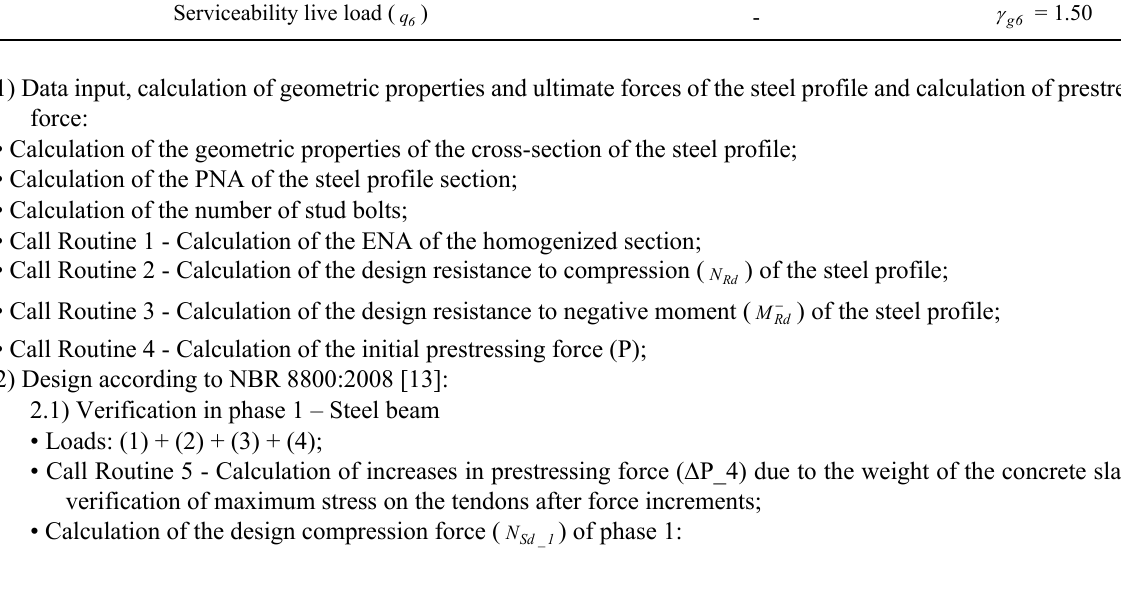
Table 2. Loads safety fator ( γ ) Loads Before Concrete Casting After Concrete Casting Weight of the steel beam ( ) ' γ = 1.15 g1 γ = 1.25 1 g g1 Prestressing force on steel tendons ( P ) ' g2 γ = 1.20 g2 γ = 1.20 Weight of the concrete slab ( ) ' γ = 1.25 g3 γ = 1.35 3 g g3 Serviceability dead load ( ) - g5 5 g